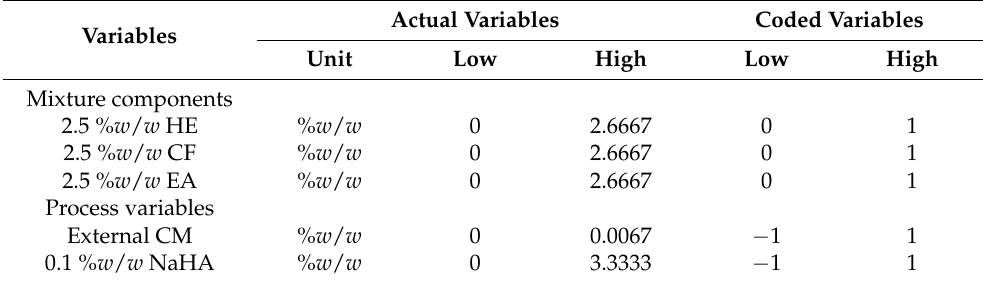
Table 5. Variables used in MPV